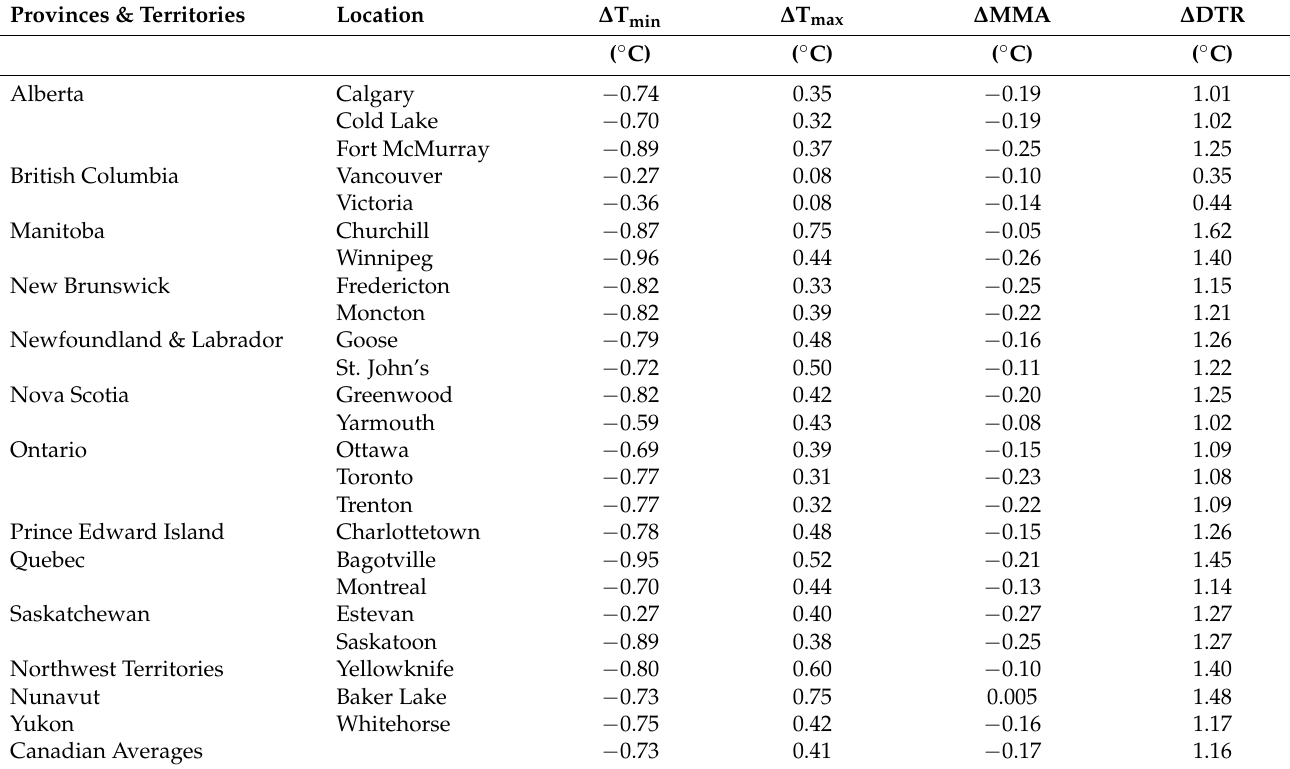
Table 3. Discrepancies between COW 0–24 and COW N–D annual averages of diurnal temperature indices. All temperature data examined in this study represent hourly measurements obtained from Canadian international or regional airports using consistent observation standards. Large differences in temperature trends and discrepancies between individual data sets are the result of regional climate differences. ∆ T min represents differences between COW 0–24 and COW N–D minima, while ∆ T max represents differences between COW 0–24 and COW N–D maxima. MMA stands for Min-Max Averages, while DTR stands for the Diurnal Temperature